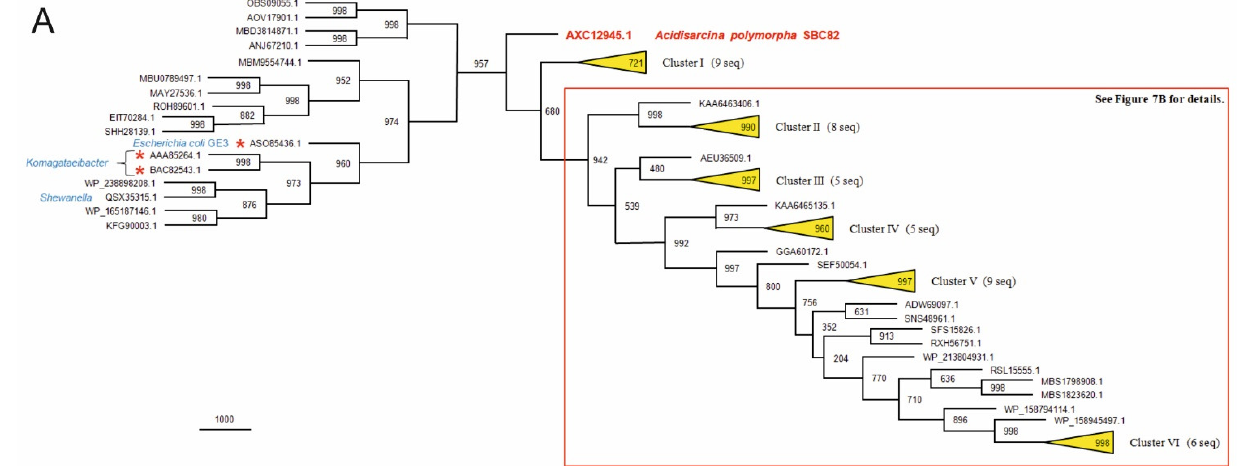
Figure 7. The maximum parsimony phylogenetic tree of the acidobacterial catalytic subunit BcsAB of cellulose synthase. Statistical significance of the tree was assessed by bootstrap analysis; the num- ber of supporting pseudoreplicates (out of 1000) is indicated next to each branching site. ( A ) A sim- plified scheme of the phylogenetic tree with six undisclosed branch clusters (I–VI) of closely related proteins. The bootstrap support of each cluster is given within the corresponding triangle, and the number of proteins is indicated next to the triangle. Cluster I contains nine proteins encoded by metagenomes